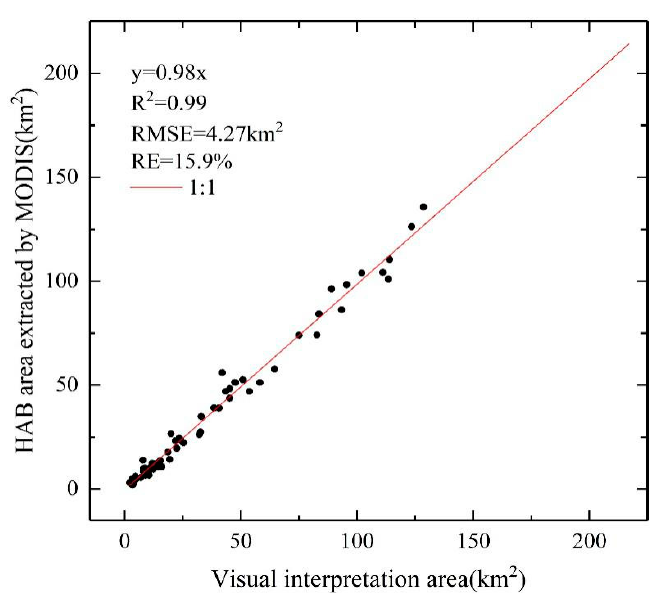
Remote Sens. 2021 , 13 , x FOR PEER REVIEW Figure 7. Comparison of HAB extracted by MODIS and visual interpretation. Figure 7. Comparison of HAB extracted by MODIS and visual interpretation.